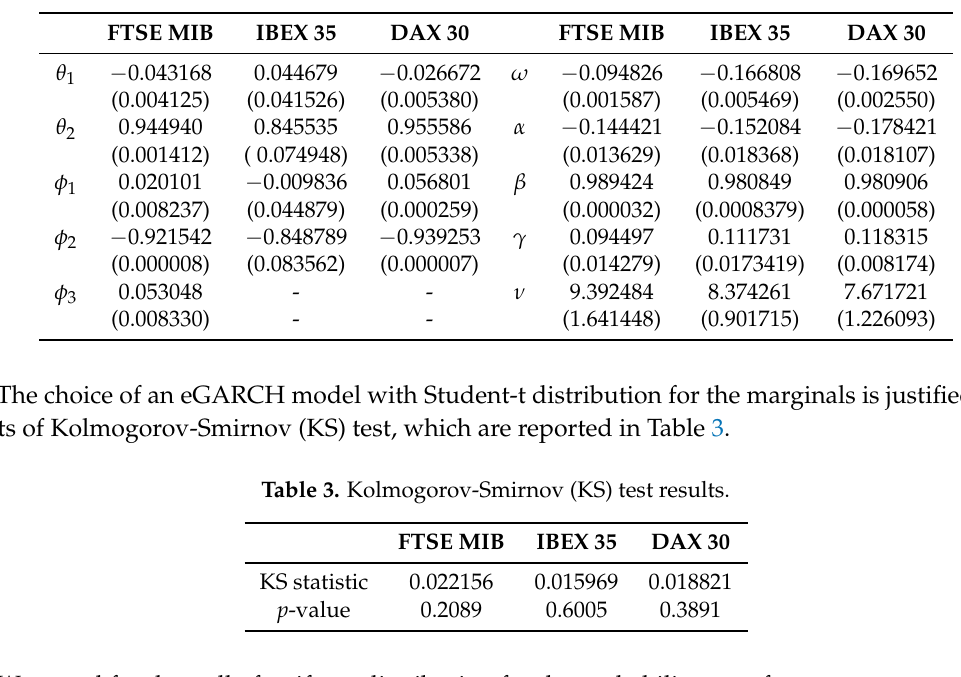
Table 2. Fitted coefficients and standard errors.